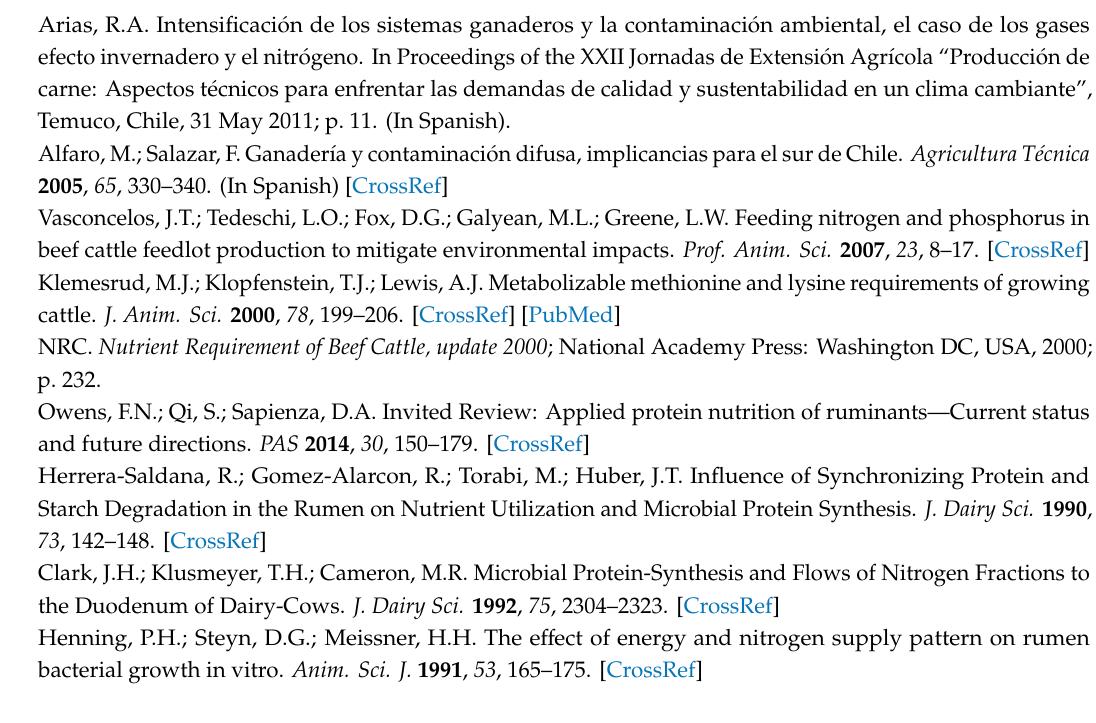
Figure S1: Adjusted degradation curves of the OM and CP, Table S1: Values of the in situ degradation characteristics of OM and